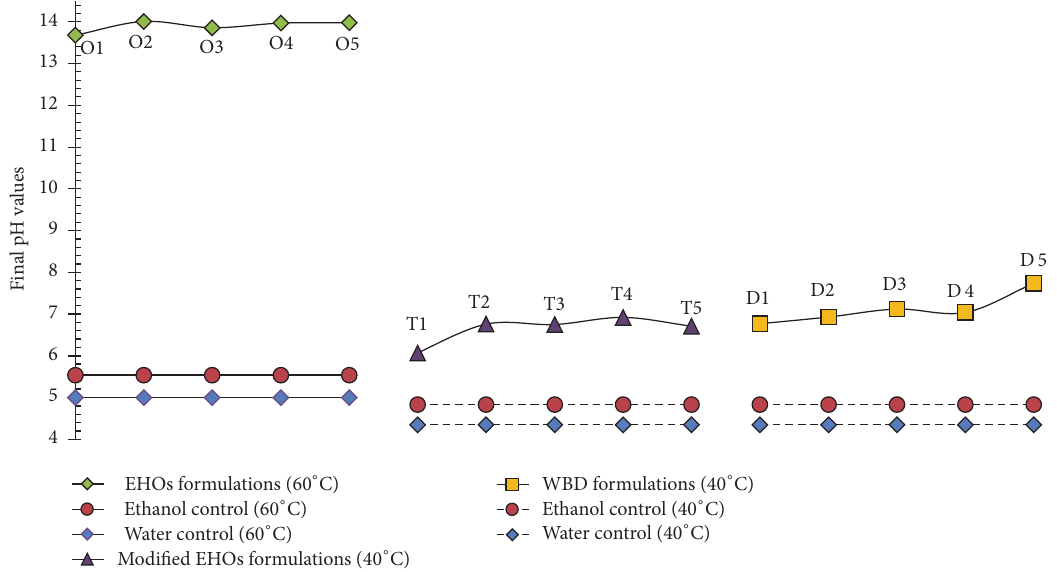
Figure 2: Final pH values of different detergent formulations at the end of the process. Note: Detergent formulations are listed in Table 2. All samples solutions were incubated for 1h at 200 revolutions per minute before analysis. The final pH values of solutions were analyzed at room temperature (25 ∘